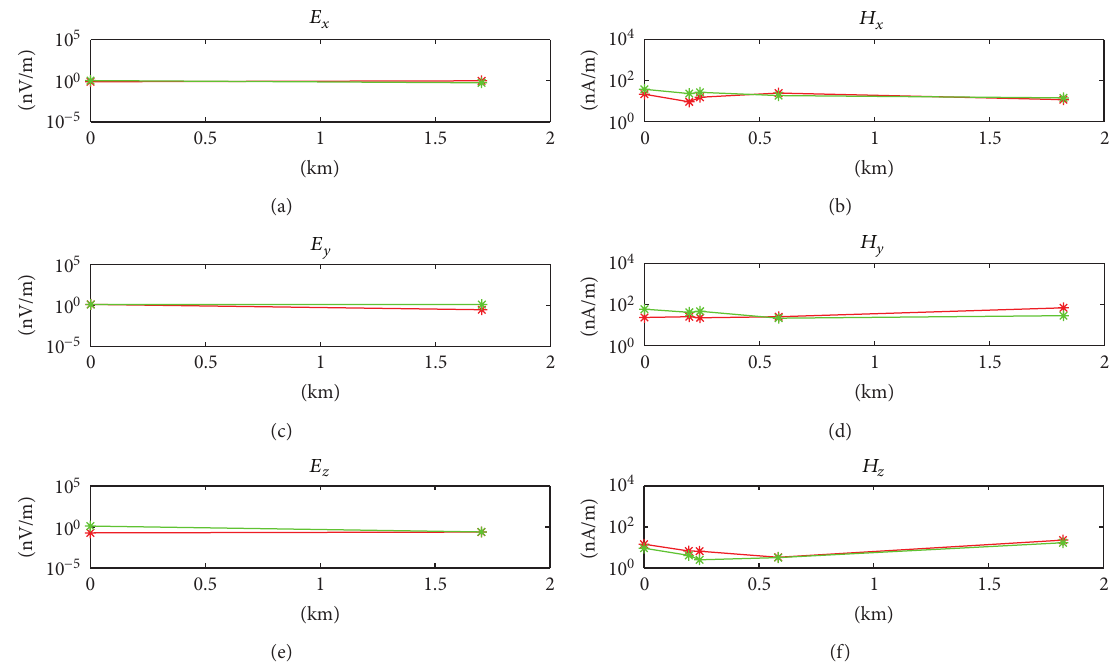
Figure 8: Amplitudes of the field components (reduced to 1 A in the source) for geoelectric model resulting from trial and error at 41Hz (green lines) as compared with the observed amplitudes (red